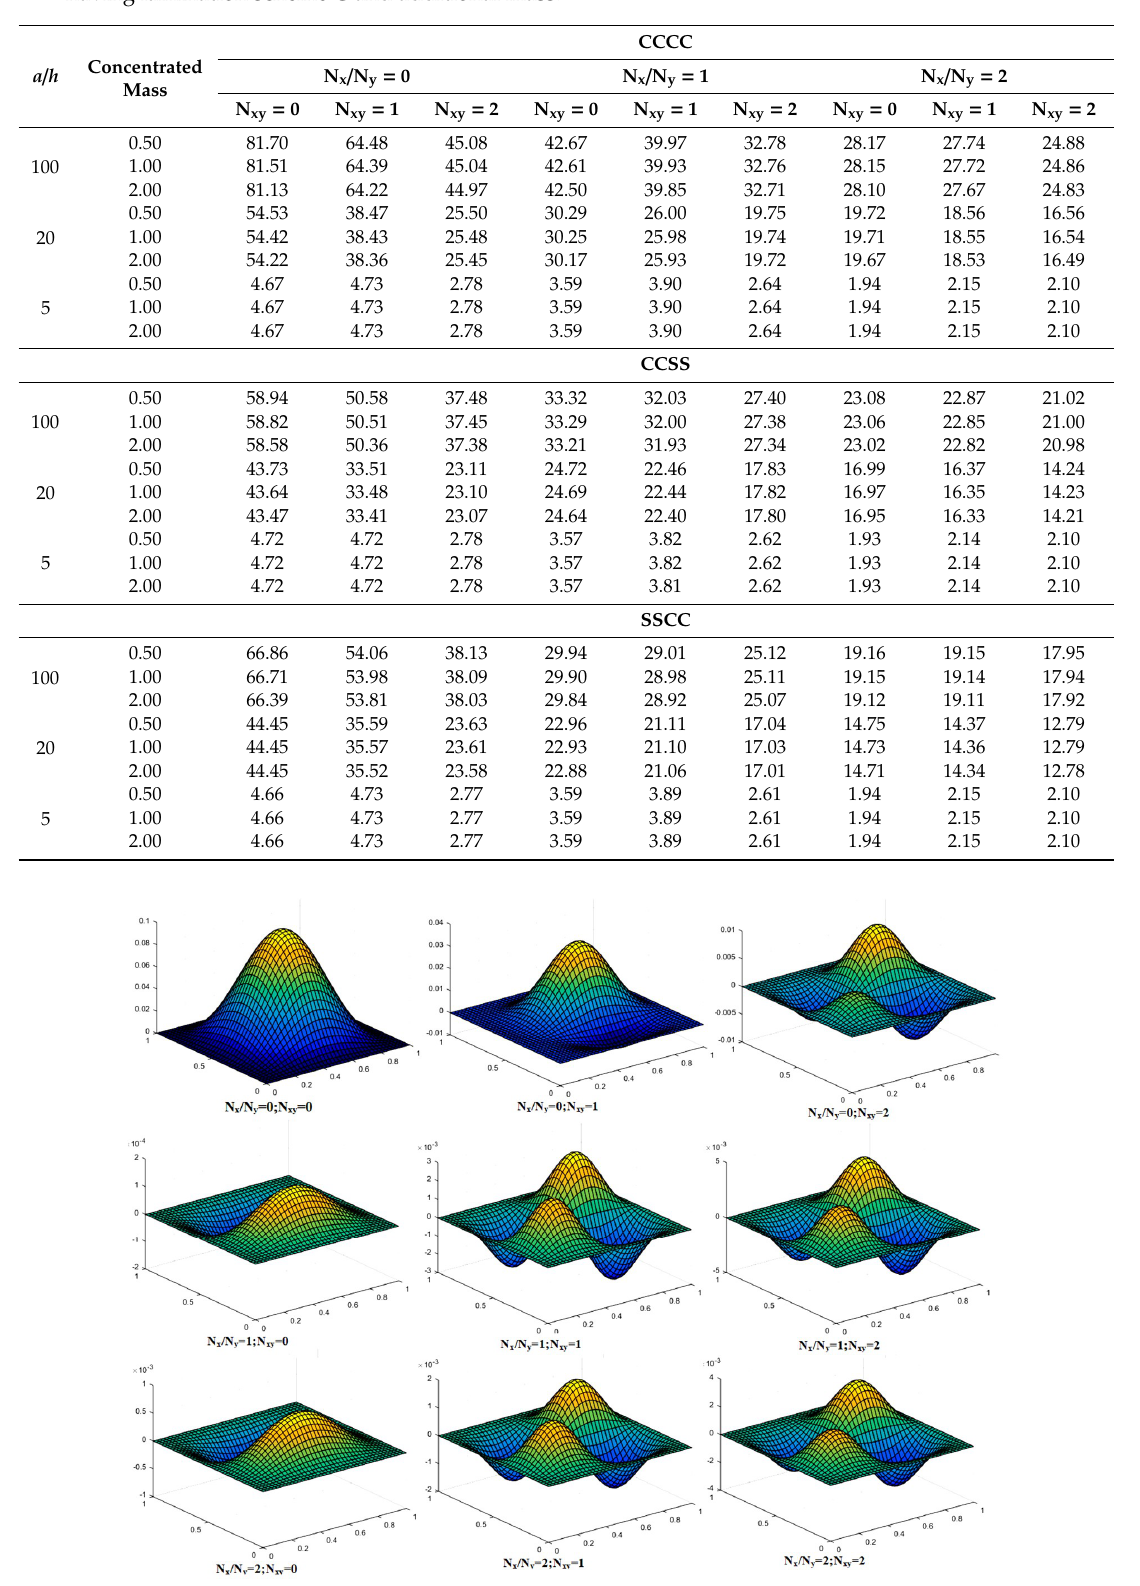
Figure 4. Mode shape for a laminated composite plate with lamination scheme A, a / h = 100, M = 0.05 and CCCC boundary condition.